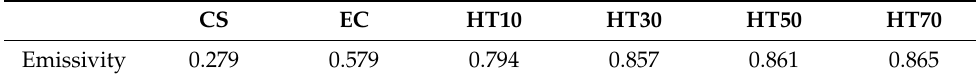
Figure 4. Emissivity of electrodeposited copper surface (CS) and electrodeposited copper surface (EC) with heat treatment for 10 min (HT10), 30 min (HT30), 50 min (HT50), and 70 min (HT70) in a wavelength range of 5–20 μ m. Table 2. Averaged emissivity of electrodeposited copper surface (CS) and electrodeposited copper surface (EC) with heat treatment for 10 min (HT10), 30 min (HT30), 50 min (HT50), and 70 min (HT70) in a wavelength range of 5–20 μ m.